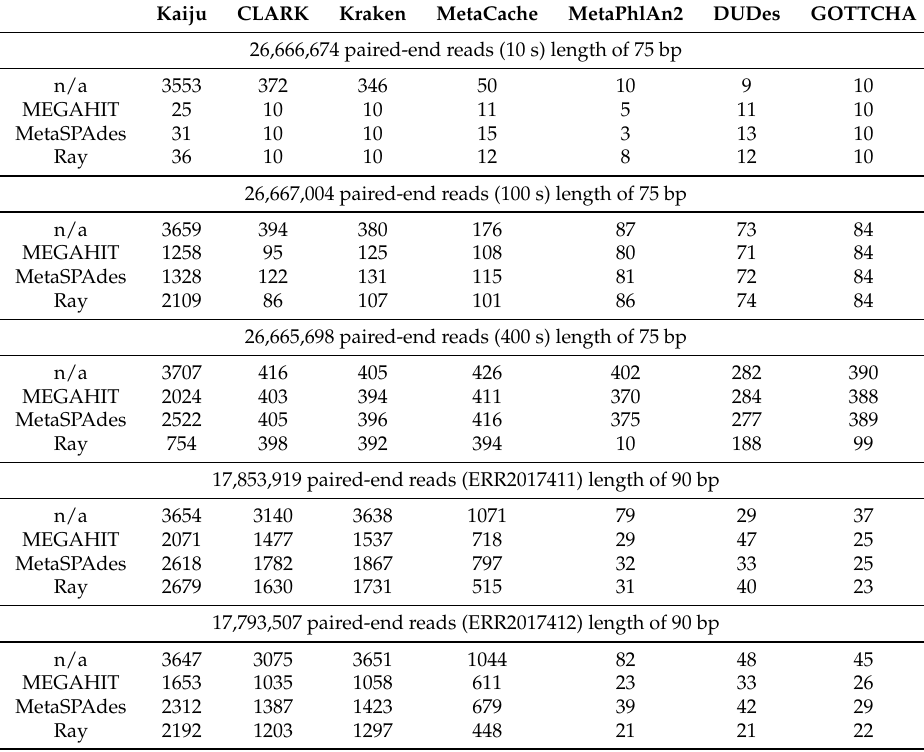
Table 3. Number of species predicted by each